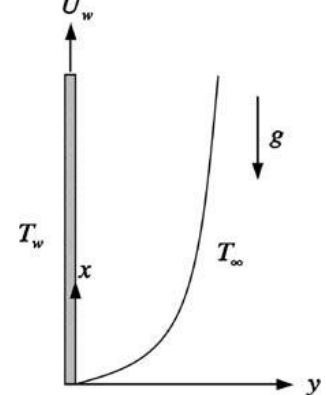
Figure 1: Physical configuration and coordinate system